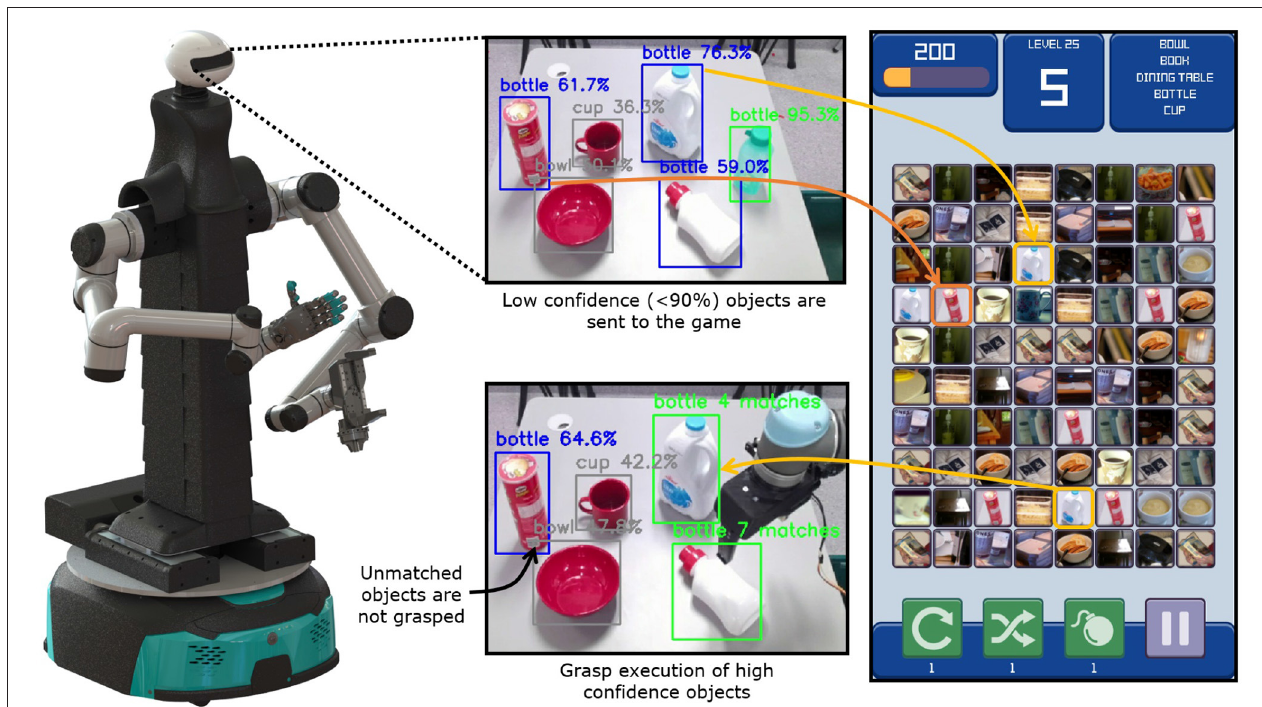
FIGURE 4 | Information flow in the object identification for the autonomous robotic grasping experiment. The camera in the robot head captures the scene image, which is processed by a pre-trained Convolutional Neural Network (CNN) ( Huang et al., 2017). The network detects and classifies the objects in the robot scene, highlighting in green the bottles with high confidence, and in blue bottles with lower confidence. The bottles with high confidence are immediately picked up and disposed of, while bottles with low confidence are submitted to the framework for identification. The server generates game instances where the players connect objects that share the same class (bottles, cups, bowls, etc.). The player matches are aggregated and the assigned classes of unknown objects are returned to the robot. As the confidence of detected bottles gets refined by the framework, they are scheduled for pick-up. The chips can is incorrectly classified by the CNN, but the players reject the classifier prediction, preventing a sorting